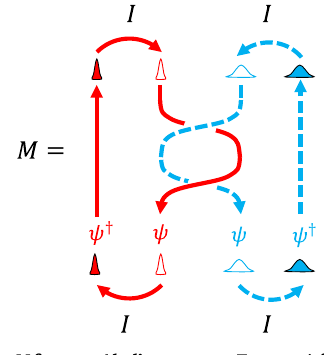
Fig. 2 | Anyon collider of upstream modes. It has counter-propagating edge channels, downstream charge modes (black arrows, label c ) and upstream neutral modes (red arrows, label n ). In this setup, the injection current I A/B,inj at QPC A/B results in the fl ow of upstream modes from QPC A/B to QPC C on Edge A/B. The locations of the charge sources (S A = B ,S 0 A = B ) and detectors (D A = B ,D 0 A = B ) are different from Fig. 1a.